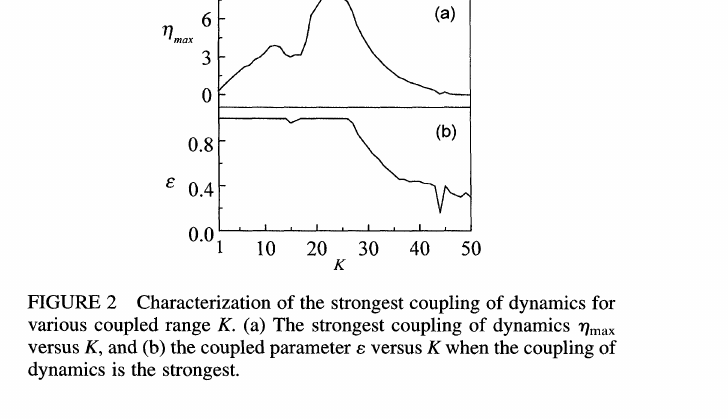
FIGURE 3 Properties of the coupling of dynamics and the Lyapunov exponents for various coupled parameter when M 101 and K 40. (a) The coupling of dynamics r/, (b) the two largest Lyapunov